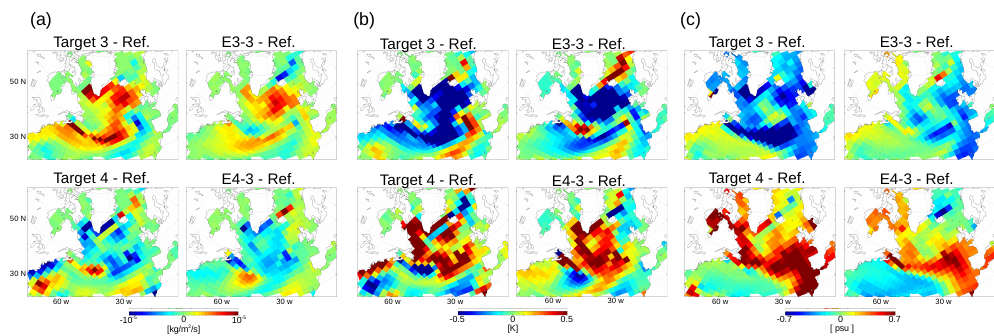
Fig. 8. Anomalies in Target 3, E3-3, Target 4, and E4-3 compared to the reference state: the freshwater flux (a) , the sea-surface temperature (b) , and the sea-surface salinity (c)